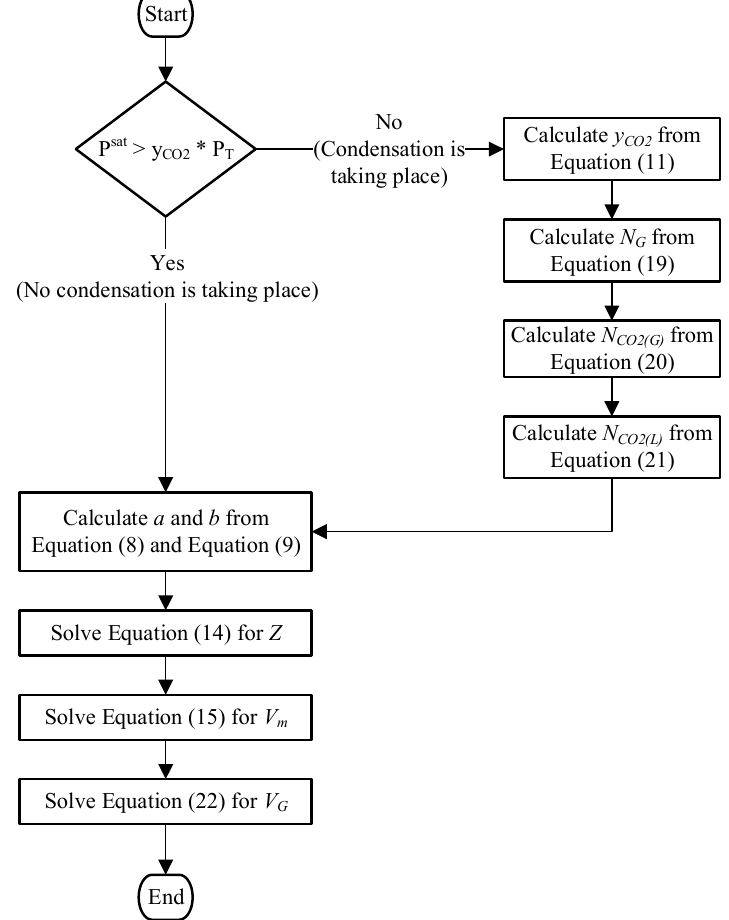
Figure 5. Solution scheme for one step in pressure.